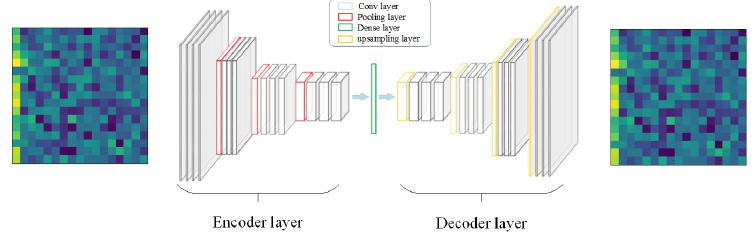
Figure 4. The convolutional autoencoder